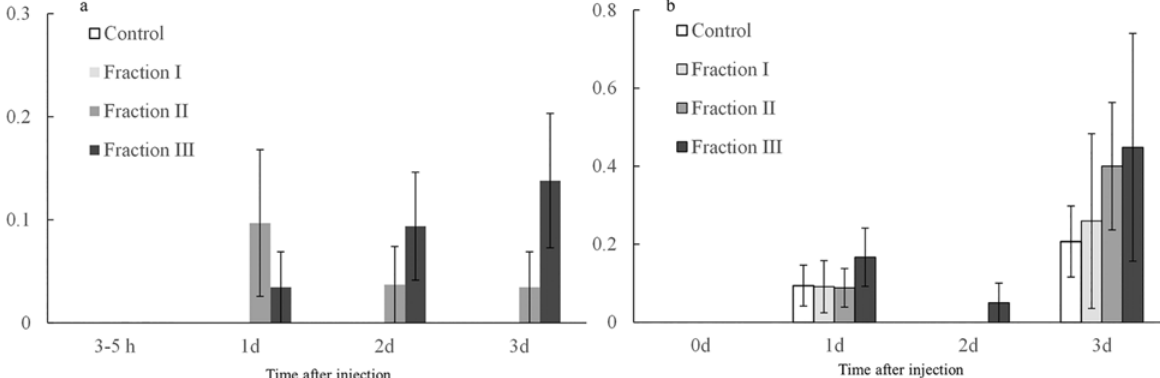
Fig 4. The total number of eggs dumped in the rearing vial by virgin females (N = 20 – 36 per block and treatment group) from the mating receptivity experiment, injected with a fraction of accessory gland extract (Fraction I [molecular weight < 25 kDa], Fraction II [MW, 25 – 50 kDa], or Fraction III [MW > 50 kDa]), or with water only (control) at 3 to 5 h, 1, 2, and 3 d after injection. The two panels and represent the two experimental blocks.